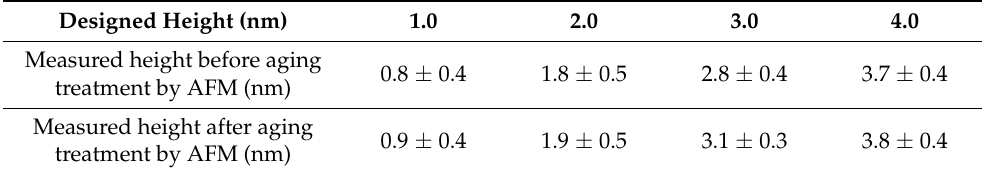
Table 2. The measured values of nano-step